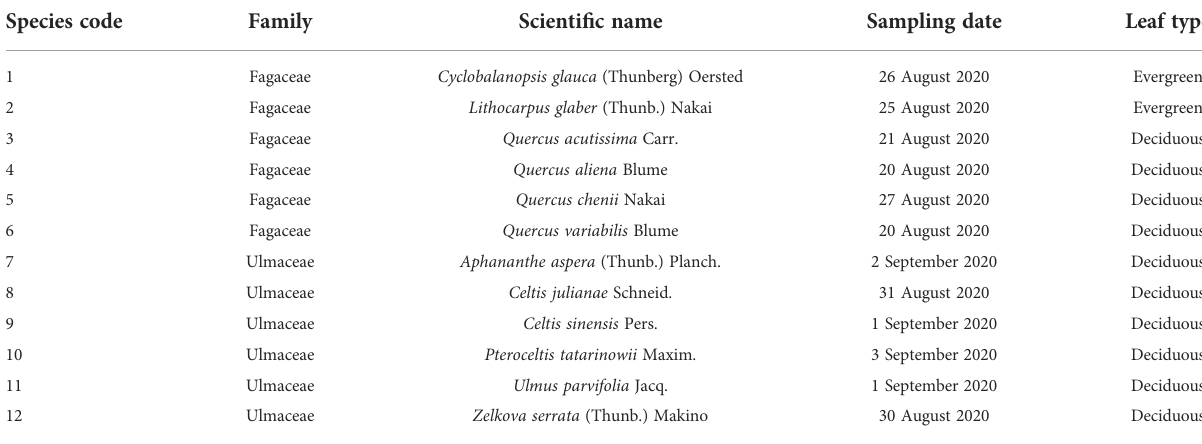
TABLE 1 Leaf collection information for the 12 species belonging to two families (Fagaceae and Ulmaceae) from Nanjing Forestry University campus, Nanjing, Jiangsu Province, P. R. China. Species